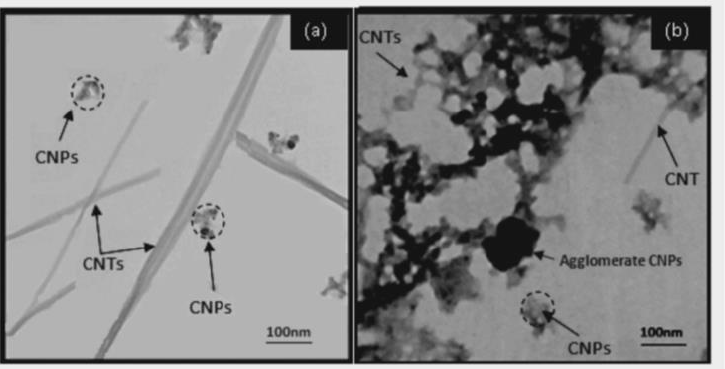
Figure 20. The effect of laser wavelength on the formation of GNS: ( a ) 532 nm and ( b ) 1064 nm. Reprinted with permission from Ref. [12]. 2020, Elsevier.